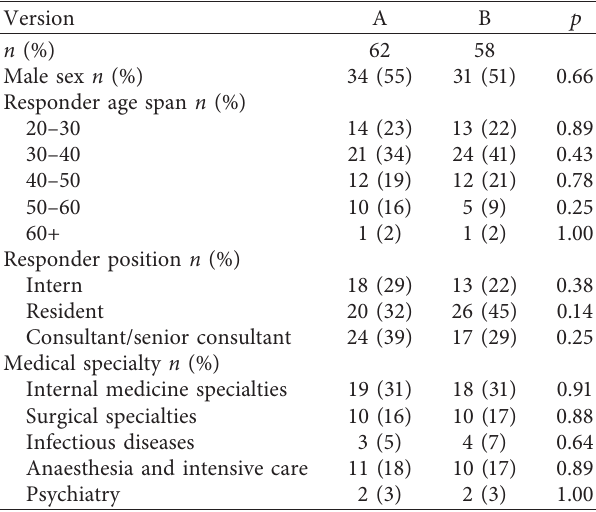
Figure 4: Case 4. Table 1: The distribution of the participants answering the two versions of the questionnaire with regard to sex, age, seniority, and medical